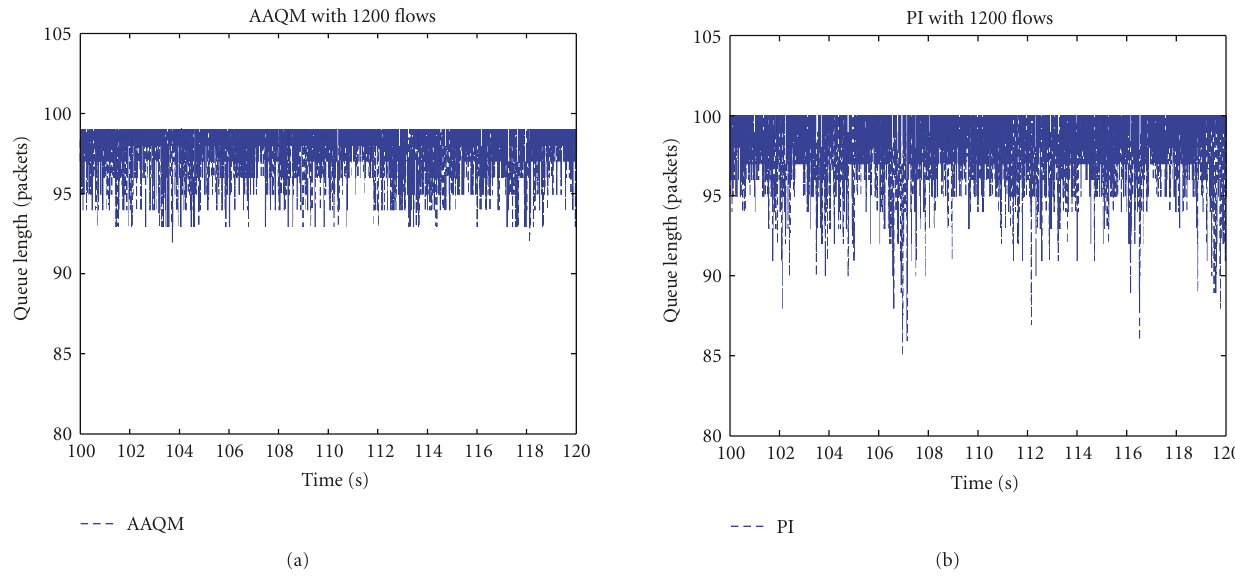
Figure 15: Comparison of instantaneous Queue Size between (a) AAQM and (b) PI at time 100 s to 120 s with 1200 flows.